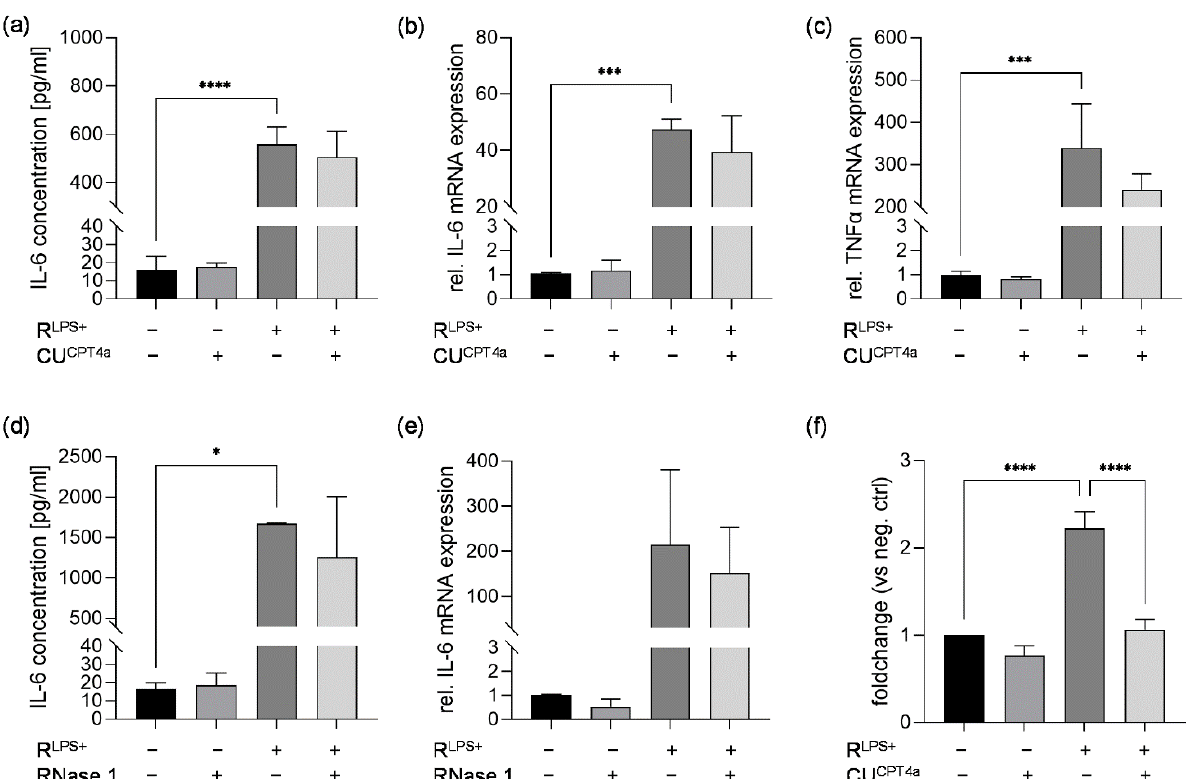
Figure 2. The effects of TLR3 inhibition or RNase 1 treatment on cardiomyocytes exposed to condi- tioned medium of LPS-stimulated macrophages in terms of cardiac inflammation and/or caspase-3/7 activation. Cardiomyocytes exposed to conditioned medium of LPS-stimulated macrophages (R LPS+ ) in the presence or absence of 40 µ M TLR3 inhibitor (CU CPT4a ) for 6 h compared with unstimulated cells and cells stimulated with the TLR3 inhibitor CU CPT4a were analyzed regarding ( a ) IL-6 protein concentrations quantified by ELISA as well as relative mRNA expression of ( b ) IL-6 and ( c ) TNF α measured by quantitative real-time PCR. ( d ) IL-6 protein concentration and ( e ) IL-6 mRNA expression of cardiomyocytes exposed to conditioned medium of LPS-stimulated macrophages (R LPS+ ) in the presence or absence of 2.8 U/mL RNase 1 for 6 h compared with unstimulated cells and cells stimulated with RNase 1. ( f ) Relative caspase-3/7 activation of cardiomyocytes exposed to conditioned medium of LPS-stimulated macrophages (R LPS+ ) in the presence or absence of 40 µM TLR3 inhibitor (CU CPT4a ) for 24 h compared with unstimulated cells and cells challenged with the TLR3 inhibitor CU CPT4a using Caspase Glo Assay. Data are presented as column bar graphs as the mean ± SD (all n = 3). One-way ANOVA followed by Tukey’s test was used for multiple comparisons. * p < 0.05; *** p < 0.001; **** p < 0.0001; LPS = lipopolysaccharide; TLR3 = toll-like receptor 3; IL-6 = interleukin-6; TNF α = tumor necrosis factor alpha; RNase 1 = ribonuclease